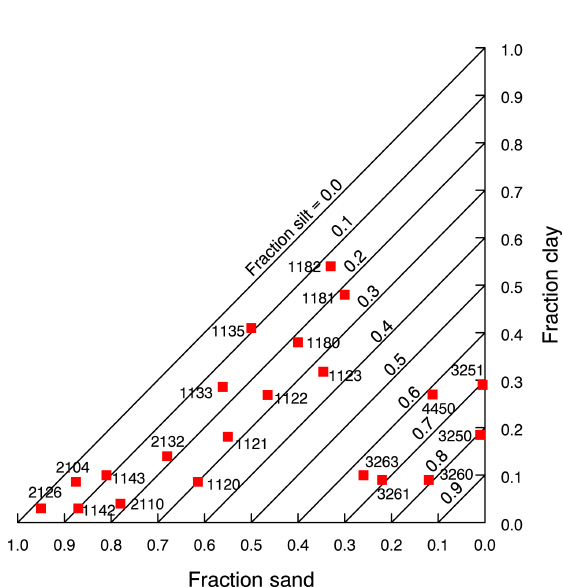
Figure C1. The positions in the texture triangle of the selected soils as indicated by their UNSODA identifier (from Madi et al.,